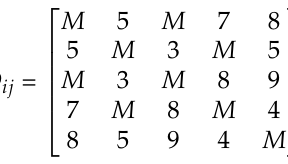
Figure 1. Area contiguity matrix.